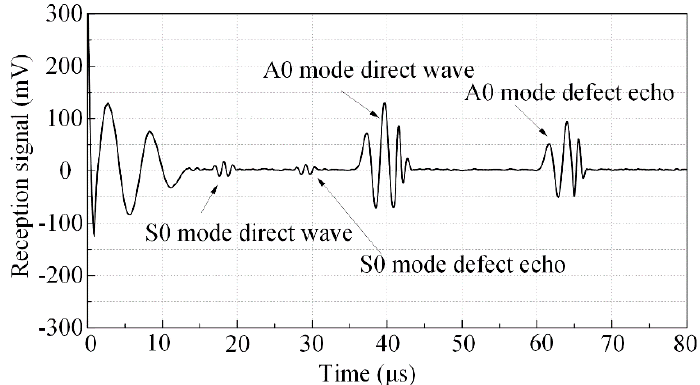
Figure 15. A0 mode Lamb wave defect detection.